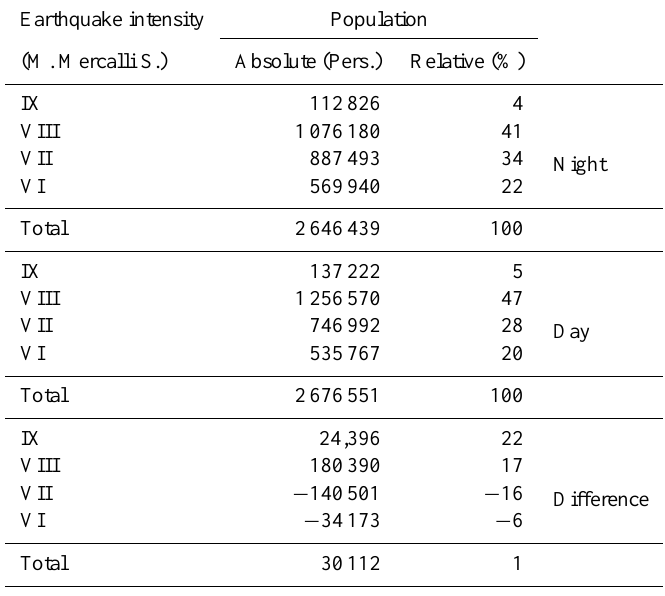
Table 3. Population exposed to seismic intensity levels in nighttime and daytime periods in the study area. Earthquake intensity